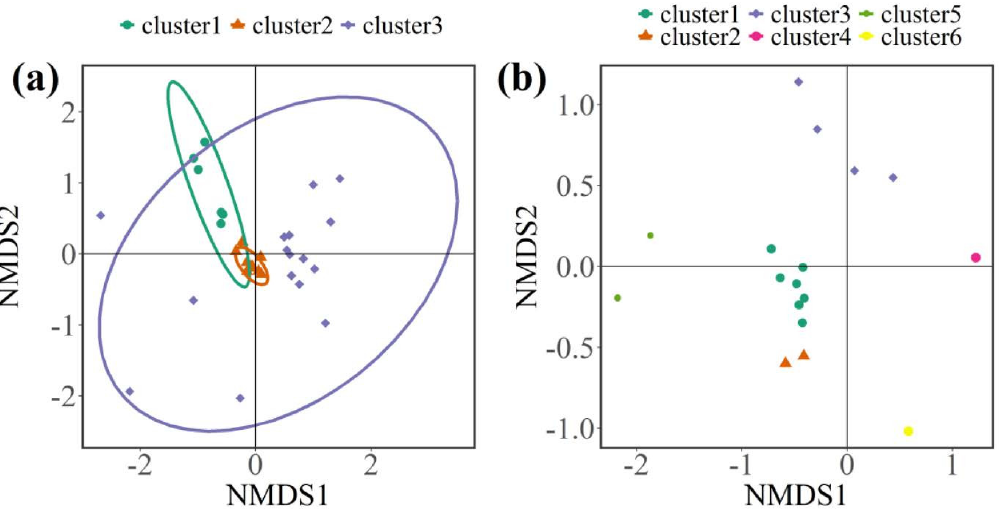
Figure 5. The non-metric multi-dimensional scaling (NMDS) ordination of species composition based on fluvial system. ( a ) NMDS ordination of native fish; ( b ) NMDS ordination of non-native fish. Points with different colors represent dissimilar species compositions of rivers, and ellipses represent the 95% confidence intervals of the two kinds of sites.